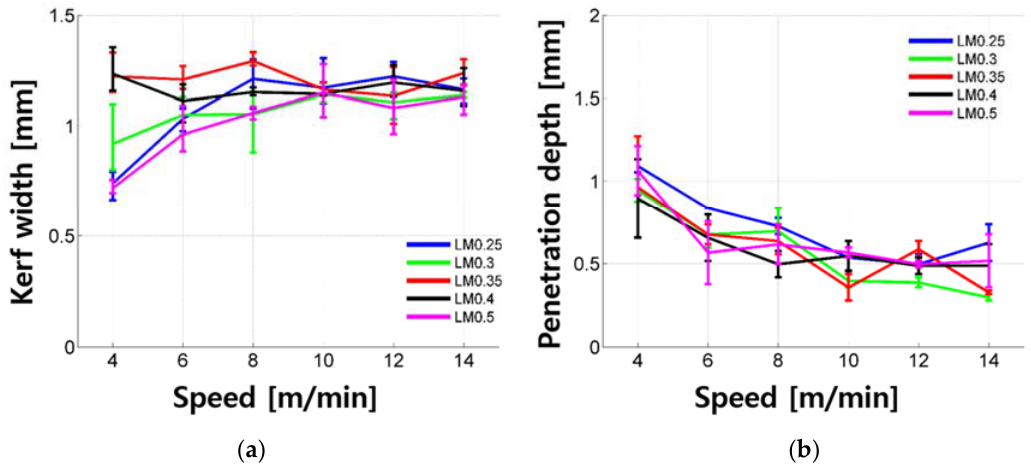
Figure 5. Kerf width ( a ) and penetration depth ( b ) vs. laser moving speed for the LM series.